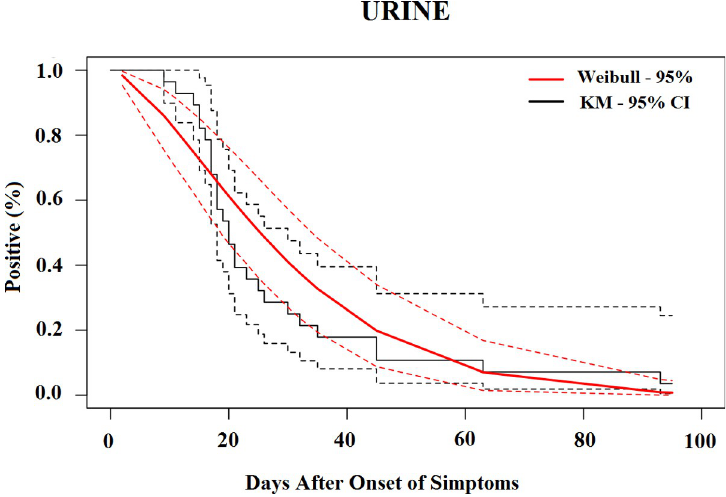
Fig 3. Survival curves (Kaplan–Meier analysis) of CHIKV RNA persistence in Urine, with Weibull fit.